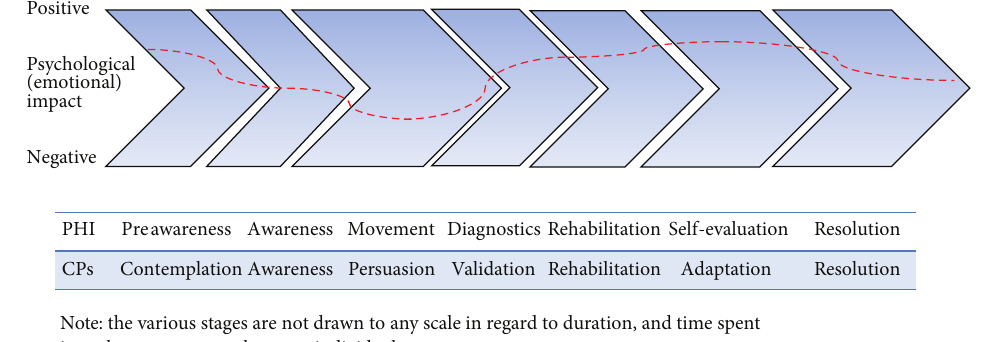
Figure 1: Models of persons with hearing impairment (PHI) and their communication partner’s (CPs) journey through hearing